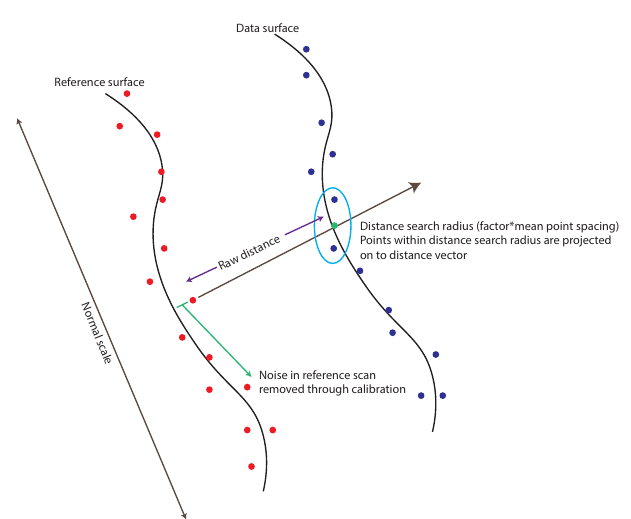
Figure 6. Drawing illustrating the distance calculation step. Raw distances are calculated along a local surface normal from the refer- ence point. The corresponding point in the data cloud is calculated as the mean of the points projected on to the normal vector that are within a radius of a specified factor of mean point